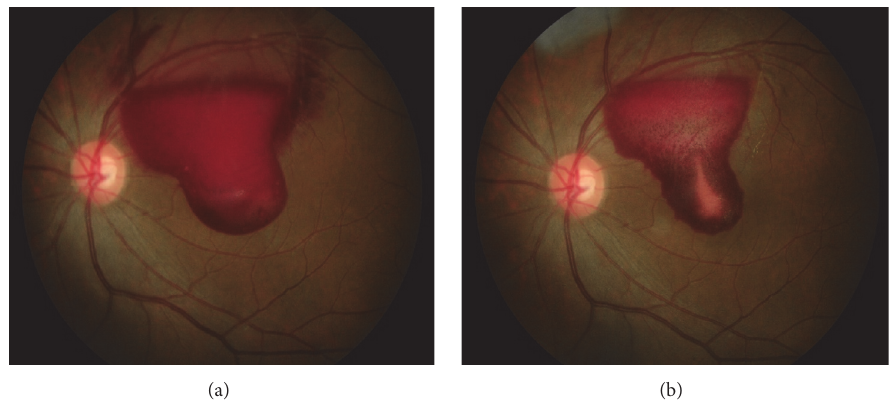
Figure 4: Case 2 at initial presentation and 2 months after initial presentation. Notes: (a) preretinal haemorrhage in the left eye at initial presentation and (b) minimal resolution of preretinal haemorrhage in the left eye at 2 months after initial presentation after conservative treatment.